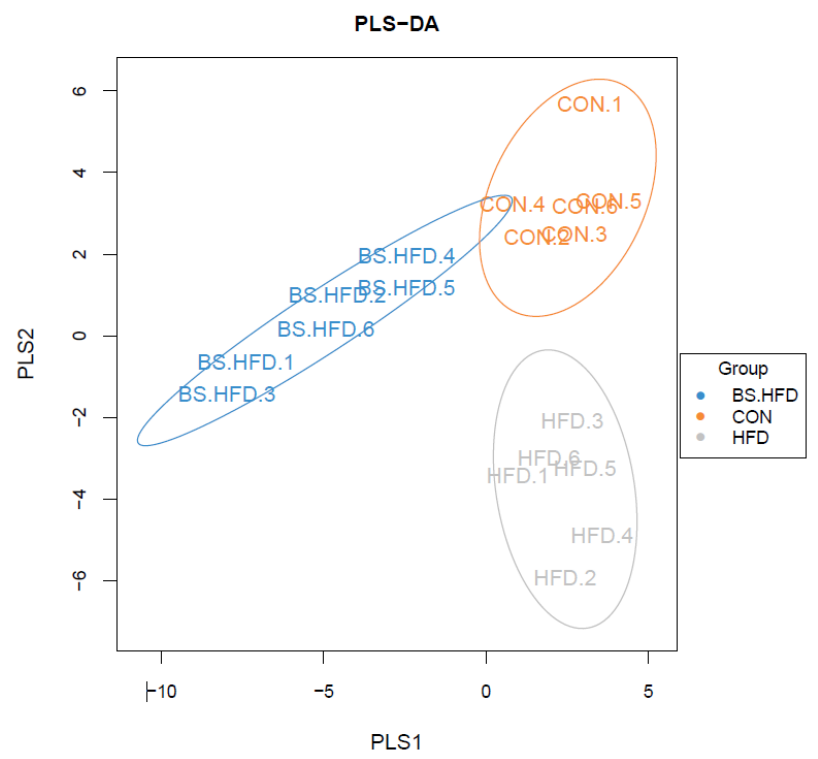
Figure 5. PLS-DA (partial least-squares discriminant analysis) of the intestinal microbiota of C. idella .